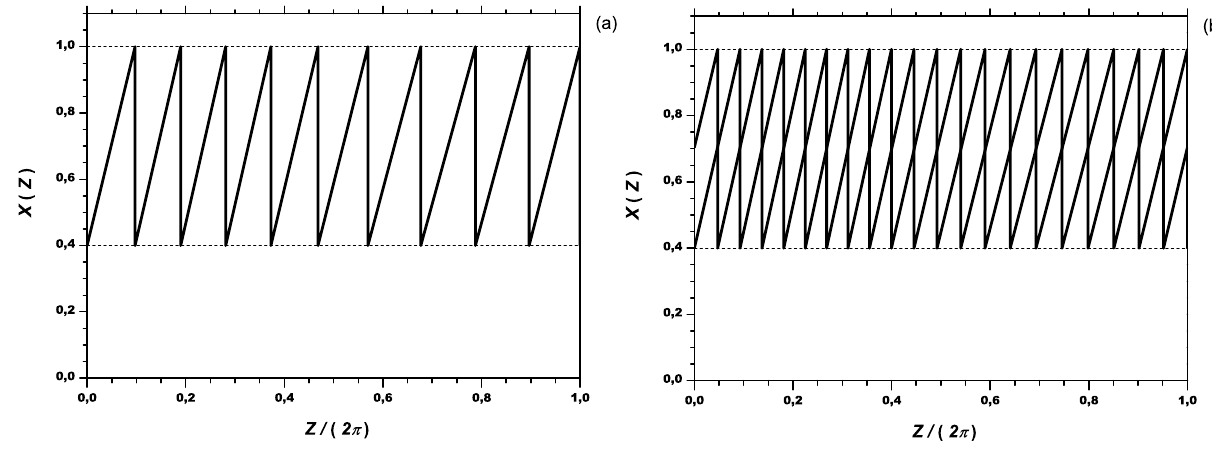
Fig. 4. Projections of the orbits in the plane XZ : (a) α = 1 / 10, (b) α = 2 / 21 ( (cid:15) = 0 . 7, A = 0 . 1).